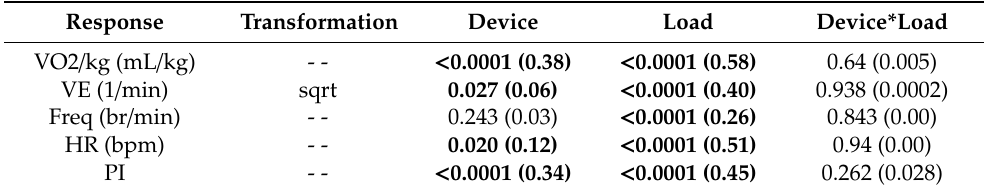
Table 1. Statistical results for the main and interactive e ff ects of the Device and Load factors on the whole-body physiological measures and perceived balance. Any transformation used to the dependent measures is indicated. p values are reported with e ff ect sized ( η 2 p ) values in parentheses. Bold fonts highlight a statistically significant e ff ect ( p < 0.05).